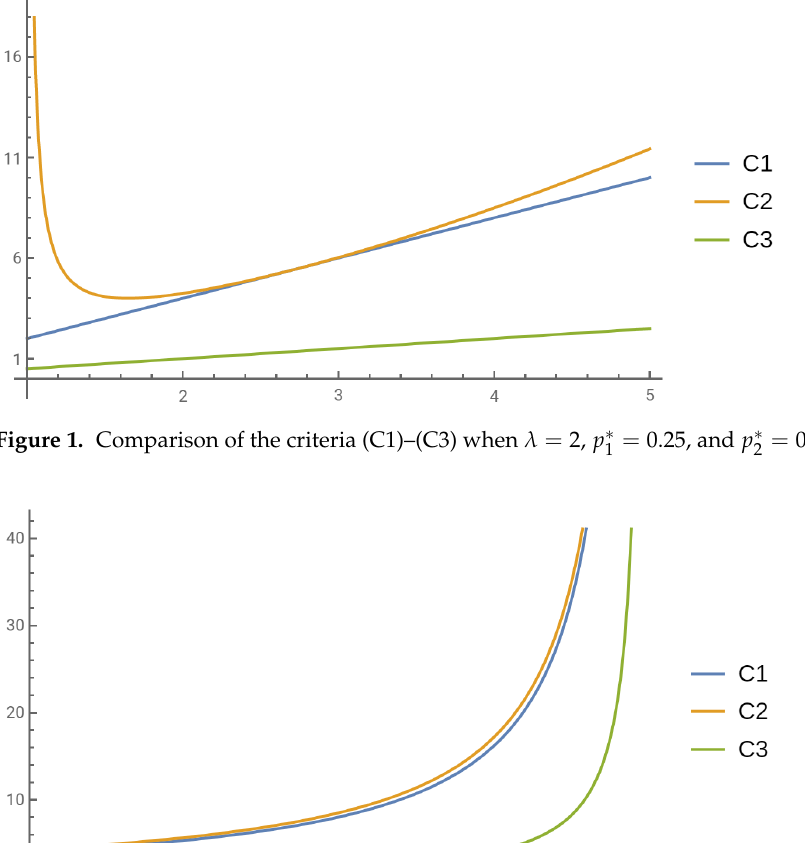
Figure 2. Comparison of the criteria (C1)–(C3) when µ = 2, p ∗